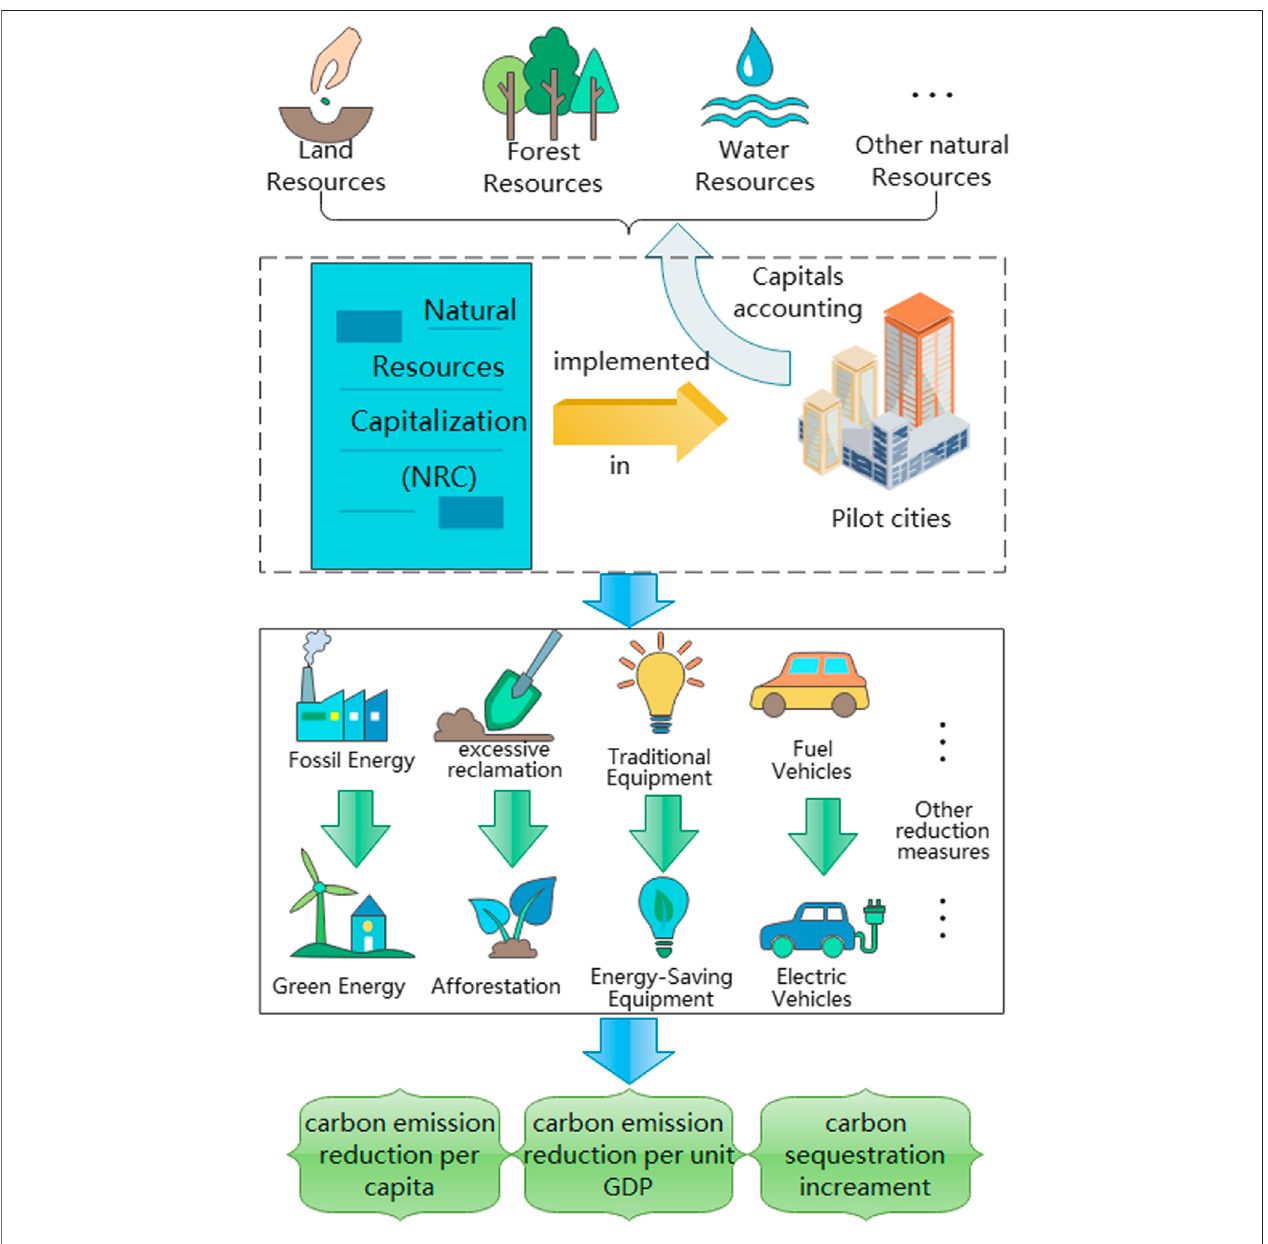
FIGURE 1 | Flowchart of NRC implementation analysis 1